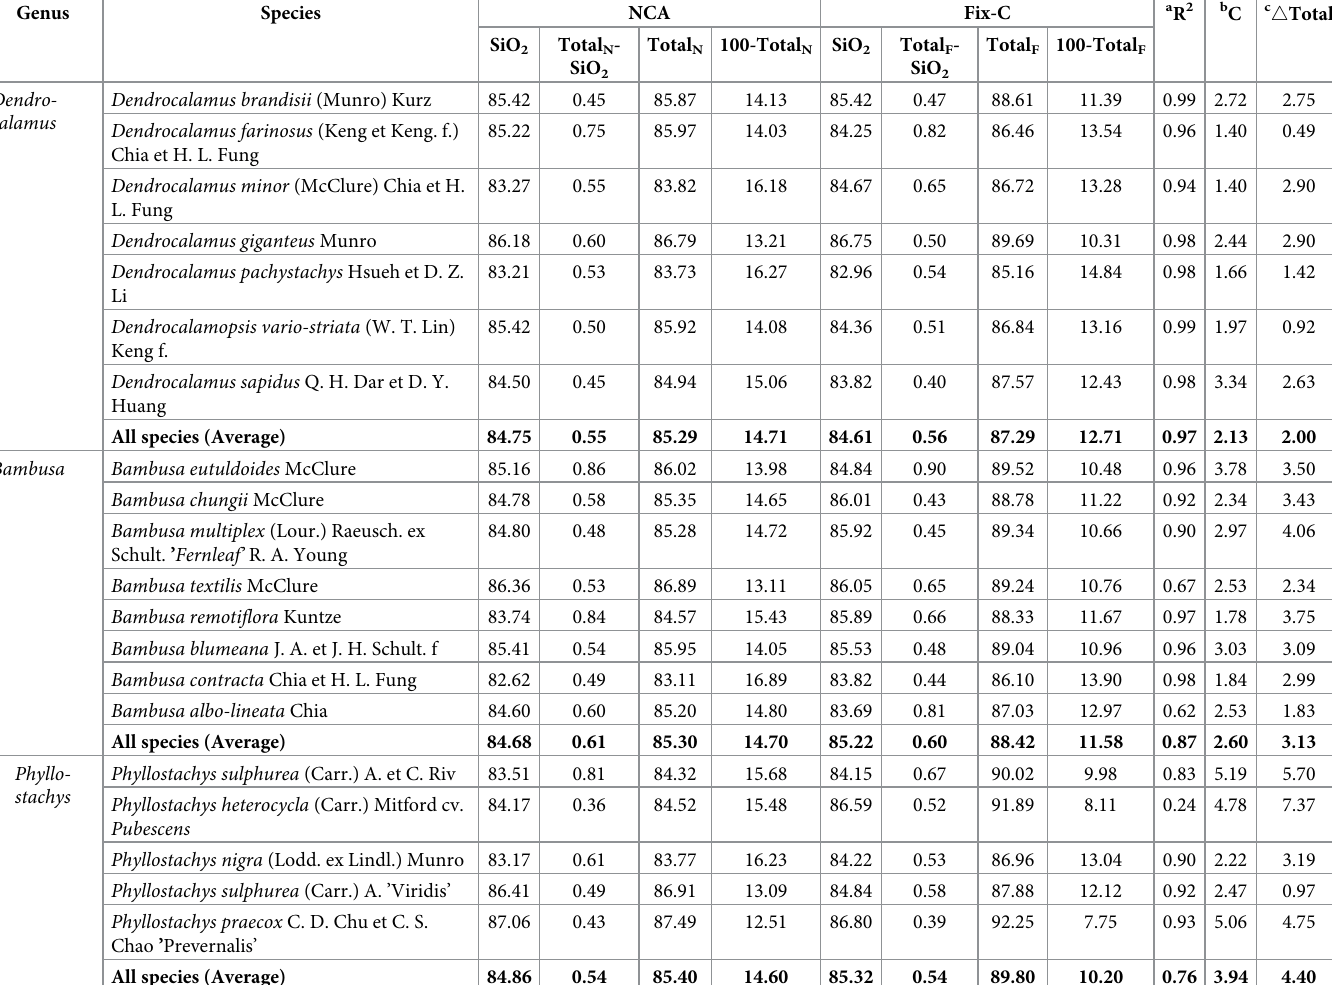
Table 4. The EPMA (using NCA and Fix-C method) results (elemental compositions and total values (wt.%)) of phytoliths in leaves of bamboo species from three genera. Genus